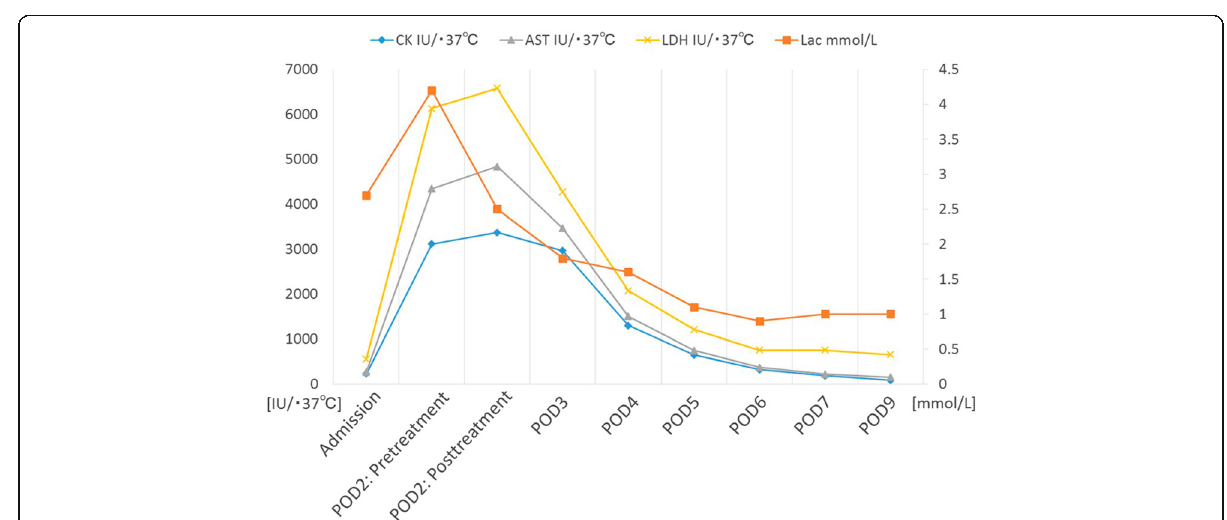
Fig. 2 Serum creatinine kinase (CK), lactate dehydrogenase (LDH), aspartate transaminase (AST), and lactate levels were elevated on POD 2. The intra-arterial infusion of a vasodilator improved laboratory